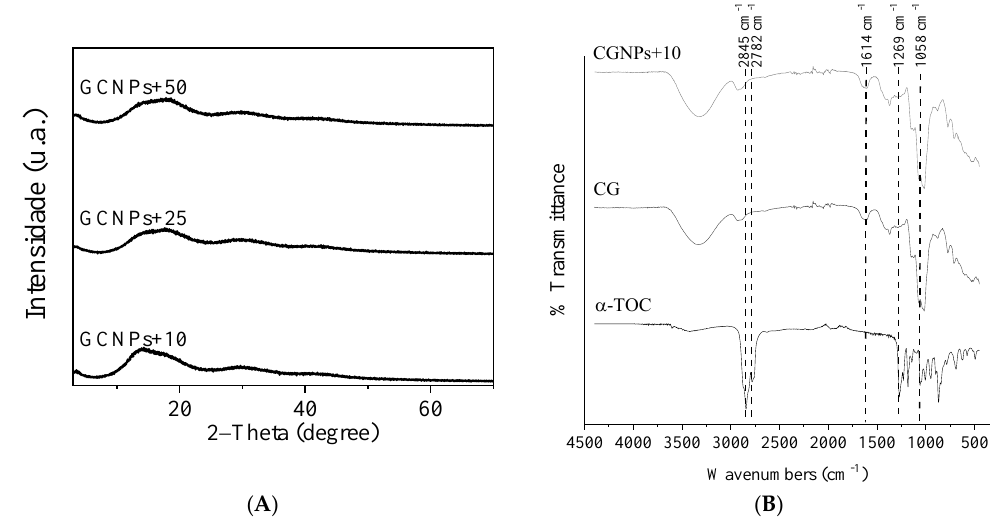
Figure 5. ( A ) X-ray diffractogram of the cashew gum particles (CGNPs) with different concentrations of α -tocopherol (10%, 25% and 50%), and with 2 θ reflection angle, monitored from 2 ◦ to 70 ◦ at a scan speed of 1 ◦ · min − 1 , 40 kV/30 mA; ( B ) FTIR spectrum of cashew gum (CG), α -tocopherol ( α -TOC), and CGNPs with 10% of α -tocopherol.